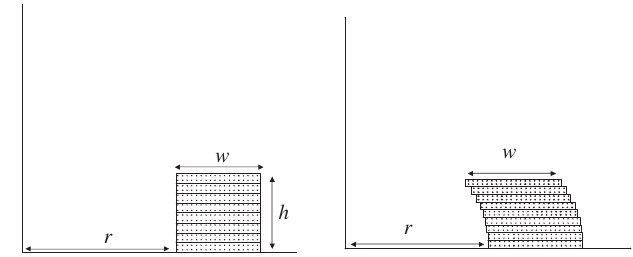
FIG. 19. (Color) Numerical evaluation of the parameter (cid:4) versus aspect ratio (41) in four different coil layouts with an aperture radius of 30 mm.